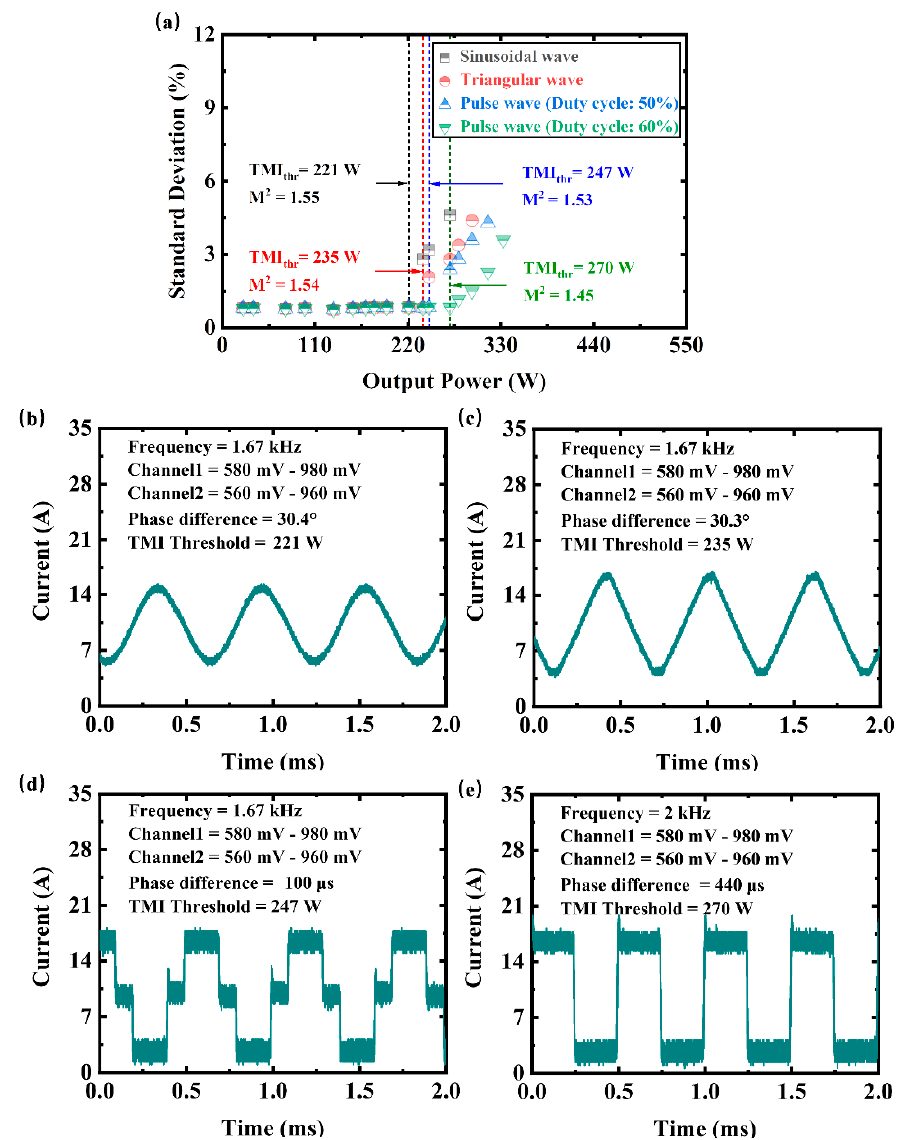
Figure 4. The output characteristic under the pump modulation of various waveforms with a certain phase difference between two channels of the function generator. ( a ) The evolution of the standard deviation of the beam fluctuations with the output power (the modulation frequency and its harmonics for the raw signals have been filtered out to calculate the temporal stability). Black dot: sinusoidal wave modulation. Red dot: triangular wave modulation. Blue dot: pulse wave (duty cycle: 50%) modulation. Green dot: pulse wave (duty cycle: 60%) modulation. The total current (blackish green line) of pump LDs at TMI threshold under the modulation of ( b ) sinusoidal wave, ( c ) triangular wave, ( d ) pulse wave (duty cycle: 50%), and ( e ) pulse wave (duty cycle: 60%). The laser output spectrum and pump laser spectrum based on pump modulation